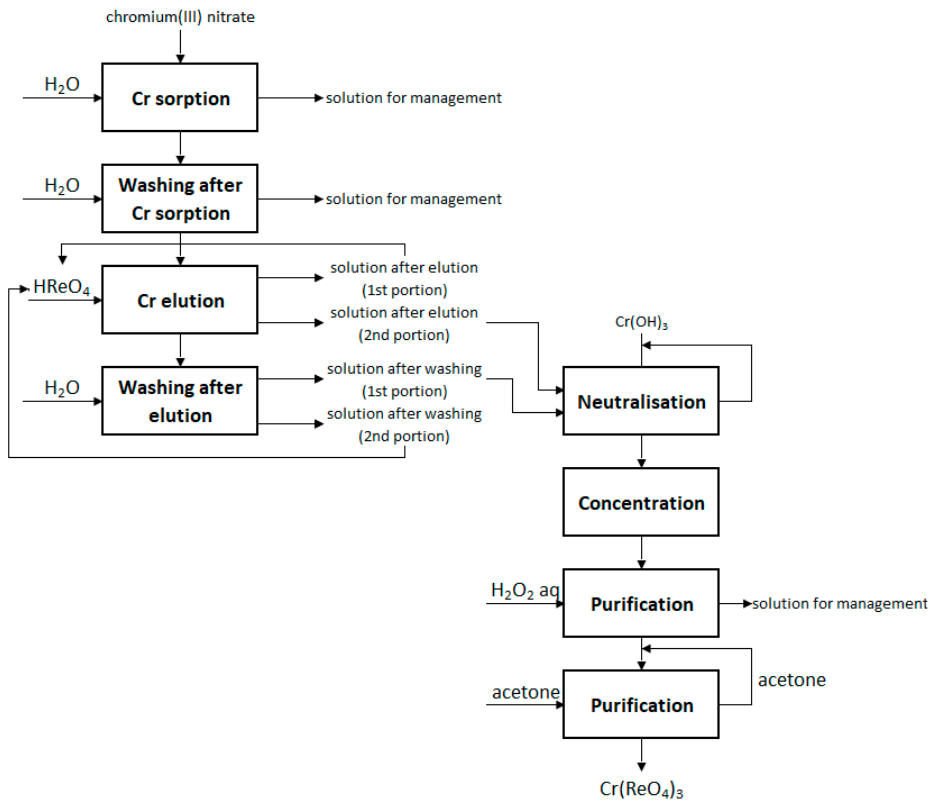
Figure 1. Scheme of Cr(ReO 4 ) 3 preparation.